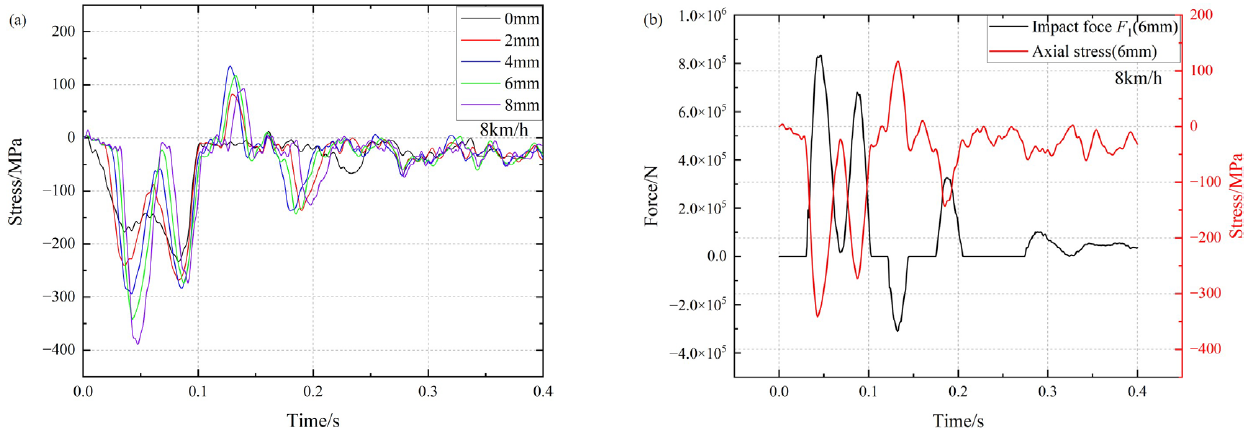
Figure 14. The variation of axial stress at A07: ( a ) at different initial clearance; ( b ) relationship with the F 1 .